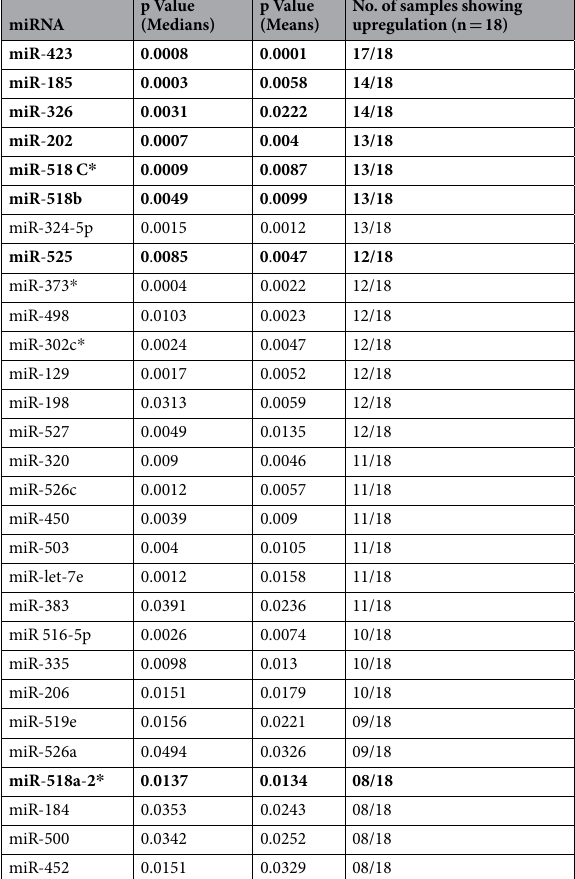
Table 1. List of micro RNAs (miRs) altered in lesional skin of vitiligo patients compared with non-lesional skin. miRNAs showed in bold were used for further